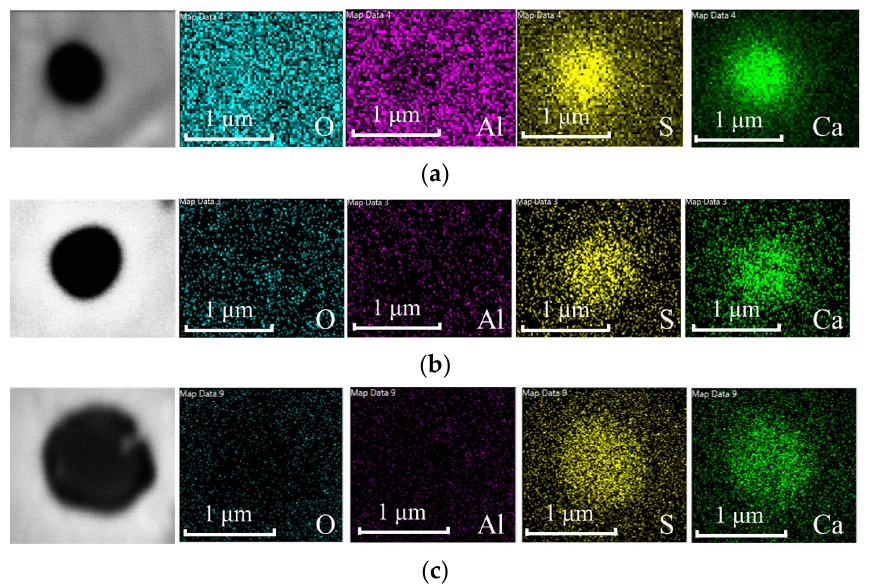
Figure 4. SEM-EDS elemental maps of CaS inclusion in ( a ) 1-min sample of Exp. 2035, ( b ) 3-min sample of Exp. 2035 and ( c ) 20-min sample of Exp. 3035.